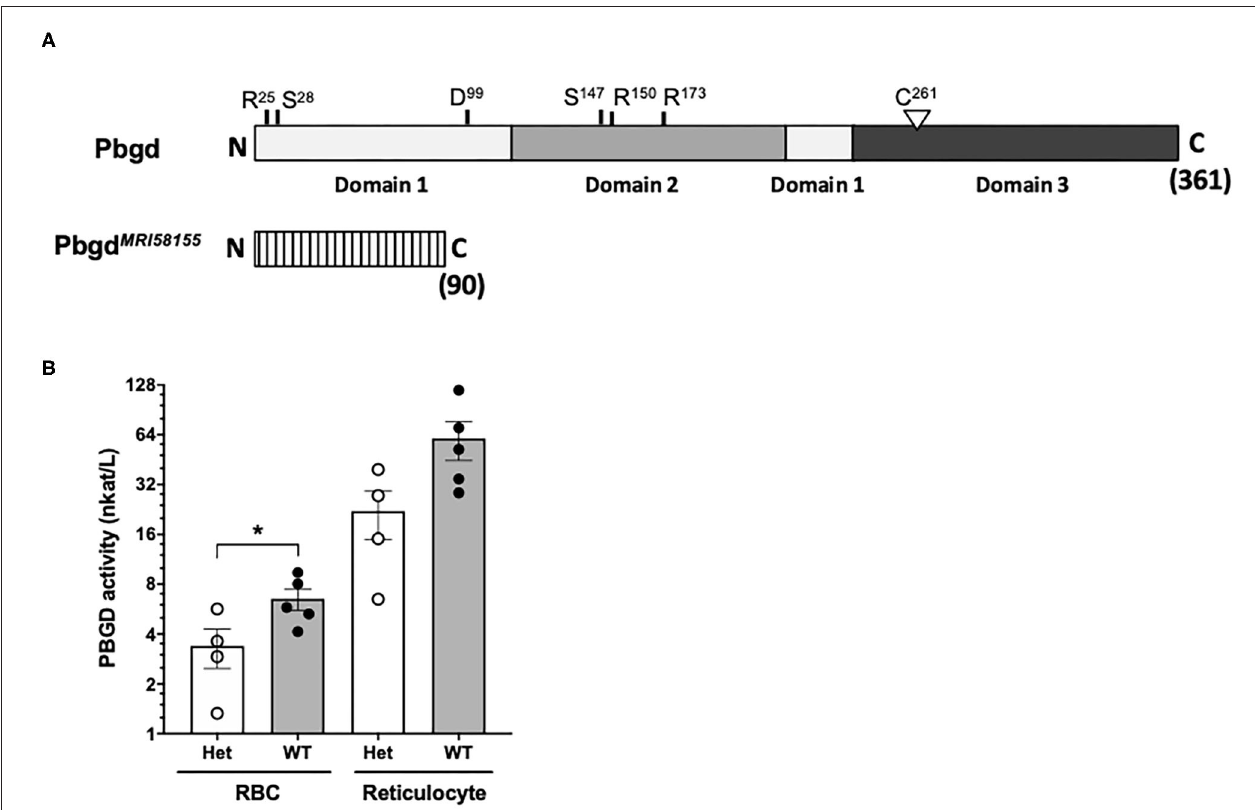
FIGURE 1 | Analysis of the Pbgd MRI 58155 mutation. (A) Schematic of the full-length 361 residue murine PBGD protein, including locations of the three domains and active site residues, R 25 and S 28 (sulfate-binding), D 99 (catalytic), S 147 , R 150 , and R 173 (pyrrole-cofactor-interacting) and C 261 (pyrrole-cofactor-binding), based on a solved human PBGD crystal structure; Gill et al. (2009). The predicted 90 residue PBGD MRI58155 protein is shown below. Its lacks the sequences containing the catalytic domain and cofactor binding sites. (B) Measurement of PBGD enzyme activity in whole blood samples from WT and Het mice using HPLC. Data represent the mean (box) and values from four mice per group, each assayed two times. * p < 0.05, calculated using a two-tailed t- test assuming equal